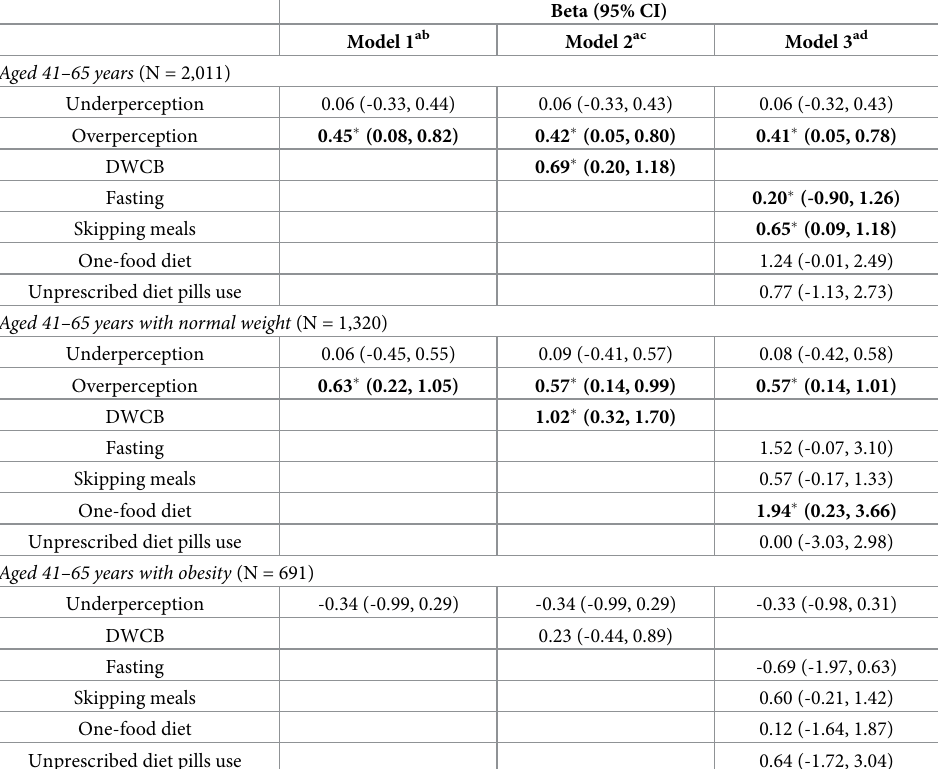
Table 5. Association of weight status perception pattern and disordered weight control behaviors with depressive symptoms (PHQ-9K) among Koreans aged 41–65 years with BMI > = 18.5kg/m 2 and no history of